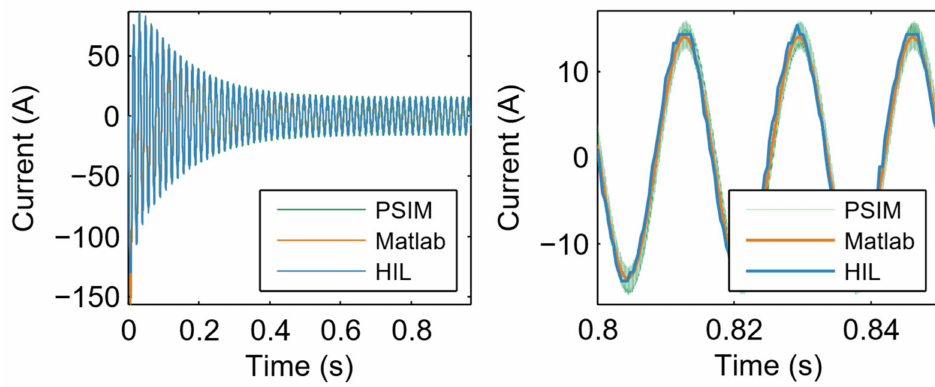
Figure 19. i a response under open loop and rectifier mode conditions.